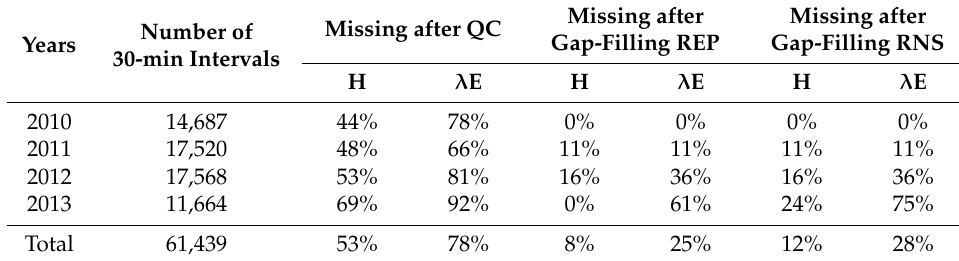
Table 3. Summary of the available flux data available before and after gap-filling, for the sensible (H) and latent ( λ E) heat fluxes. The number of 30-min intervals correspond to the number of days of the experiment. The rates of missing data are given as percentages of the number of 30-min intervals for each year. Missing after QC correspond to the sum of missing raw measurements and data eliminated by quality control (Section 2.3.2). Missing data after gap-filling are given for both way of applying REddyProc ore (REP): before separating wind directions, and (RNS) after splitting. (see Section